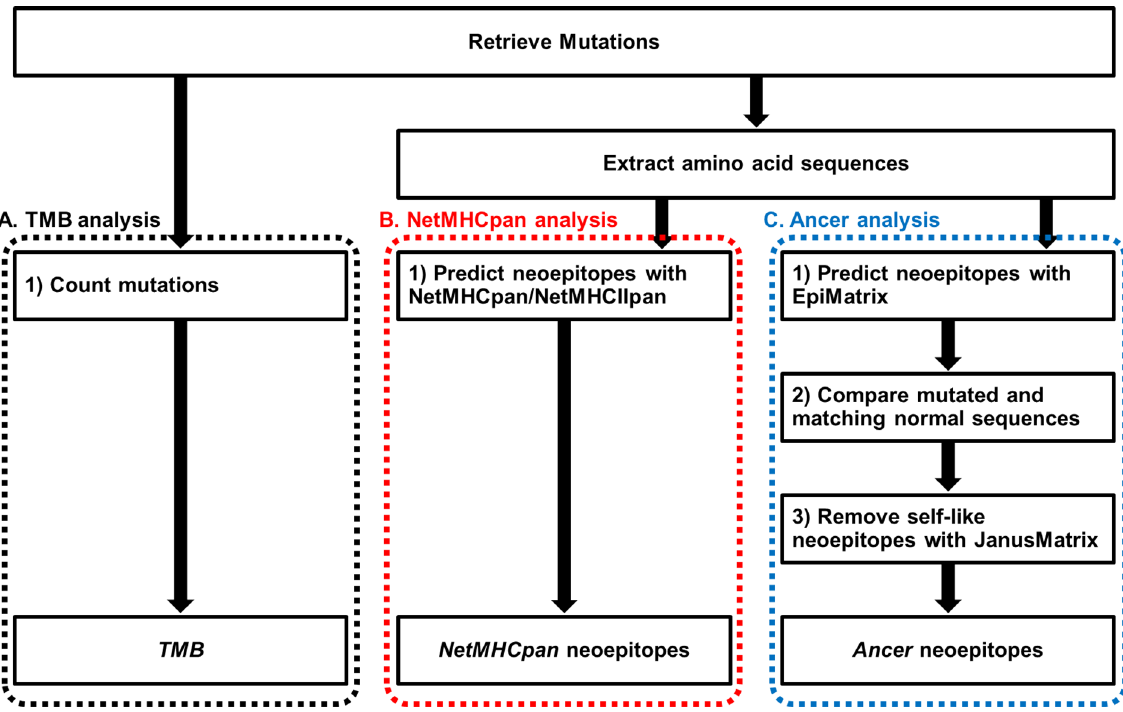
Figure 1. BLCA mutanome analysis workflow. Mutations were retrieved for each patient sample and evaluated using three analysis workflows and then compared for overall survival and disease-free survival predictive accuracy. The three types of analyses were defined as follows: ( A ) “TMB analysis”: tumor mutational burden is evaluated from the count of mutations present in each tumor. ( B ) “NetMHCpan analysis”: mutation-bearing HLA class I and HLA class II ligands are identified with NetMHCpan 4.0 and NetMHCIIpan 3.1, respectively. This approach is similar to the one employed by the TCGA Research Network in their analysis of the BLCA cohort 19 . ( C ) “Ancer analysis”: mutation-bearing HLA class I and HLA class II ligands are identified with EpiMatrix, compared to matched normal sequences to identify Ancer-defined neoepitopes, and filtered with JanusMatrix to remove neoepitopes homologous to self.